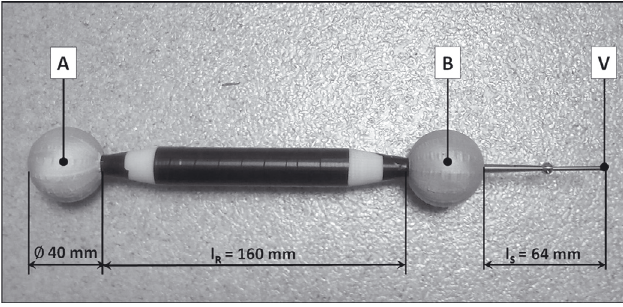
Fig. 2. Mobile measuring probe [8]. A and B are the two spherical retro-reflective markers and V is the